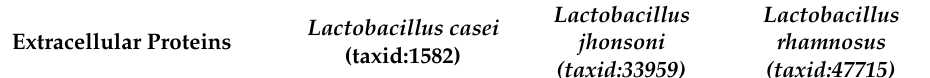
Table 5. Analysis of homology checks against probiotic bacterial targets.